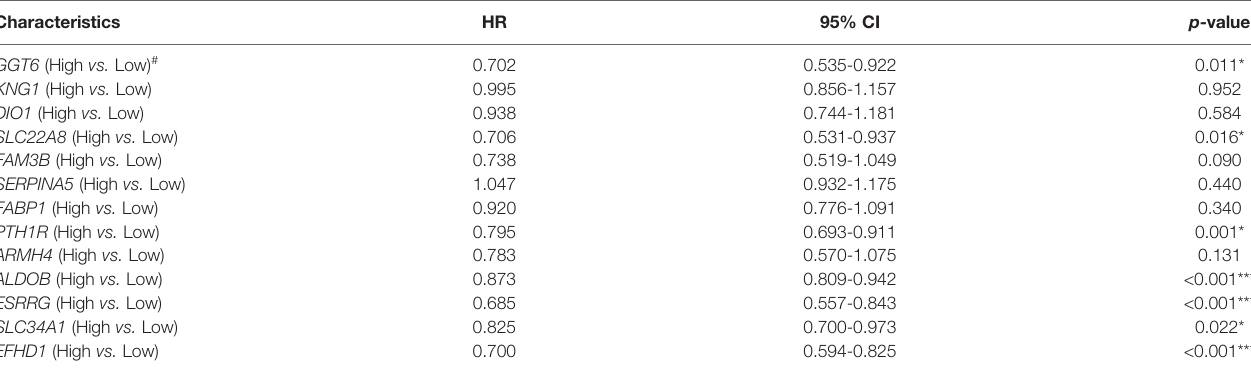
HR, hazard ratio; CI, con fi dence interval; # Samples were classi fi ed into high and low gene expression according to a cut-off of 50%; *p < 0.05; ***p <